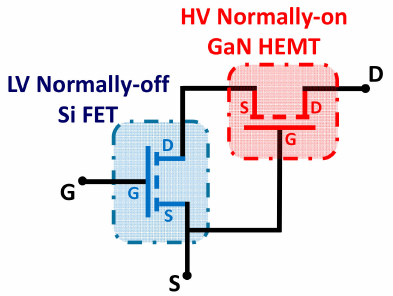
Figure 2. Normally-o ff GaN transistor obtained with the “cascode” configuration, combining a high-voltage (600 V) normally-on GaN high electron mobility transistors (HEMT) with a low-voltage (30 V) normally-o ff Si